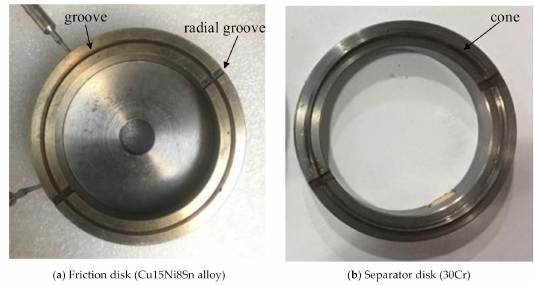
Figure 6. Conical groove friction specimens